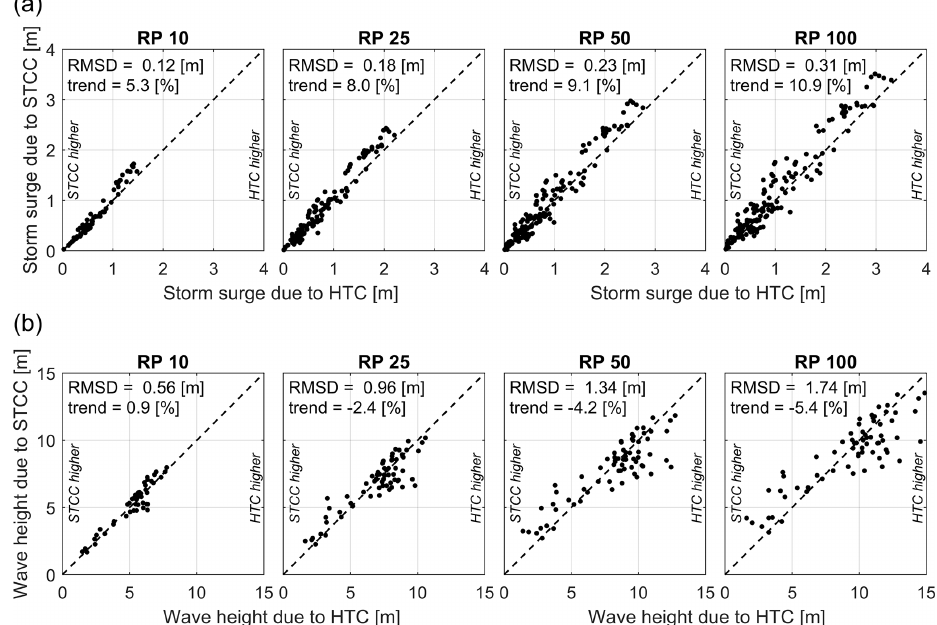
Figure 8. Scatterplots of computed storm surge (a) and wave heights (b) , both resulting from HTCs ( x axis) and STCC ( y axis), for return periods of 10, 25, 50 and 100 years, for all locations along the Bay of Bengal. Root-mean-square differences (RMSDs) and the trend (%) of STCC compared to HTCs are also shown.